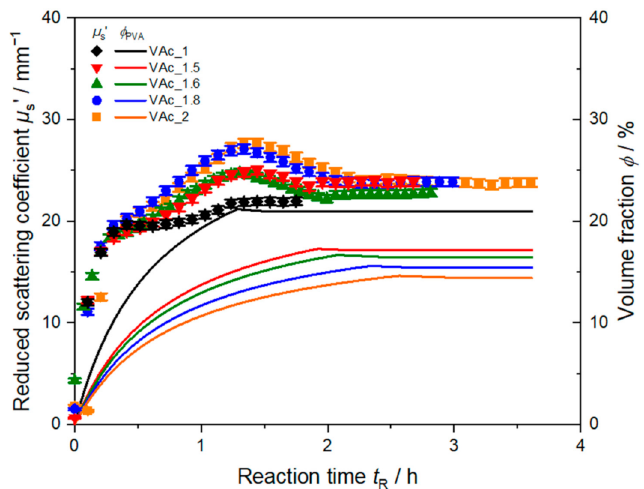
Figure 4. Comparison of inline determined reduced scattering coefficient µ s ’ at 637 nm for synthesis PVAc_1 to PVAc_2 with different feeding rates of PVA and hence volume fraction φ PVA during synthesis. Data shown without cooling phase for better